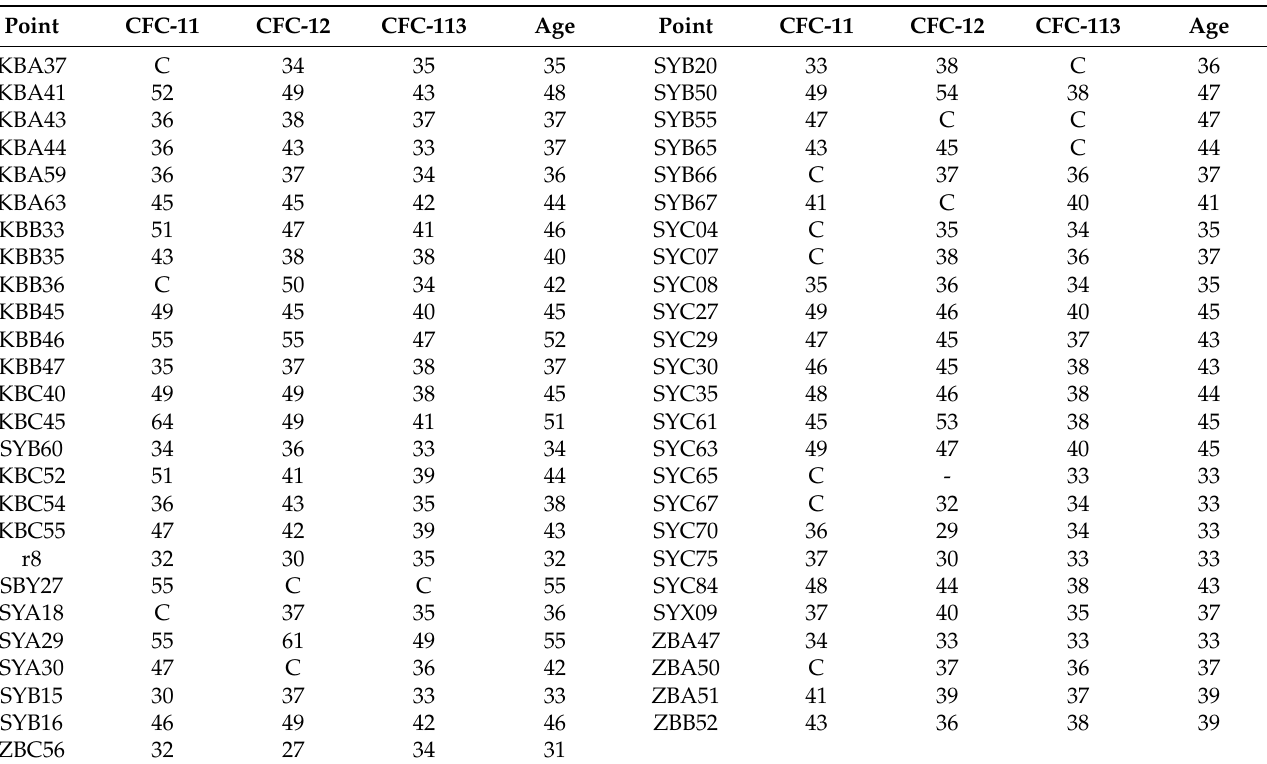
Table 3. Groundwater ages calculated by